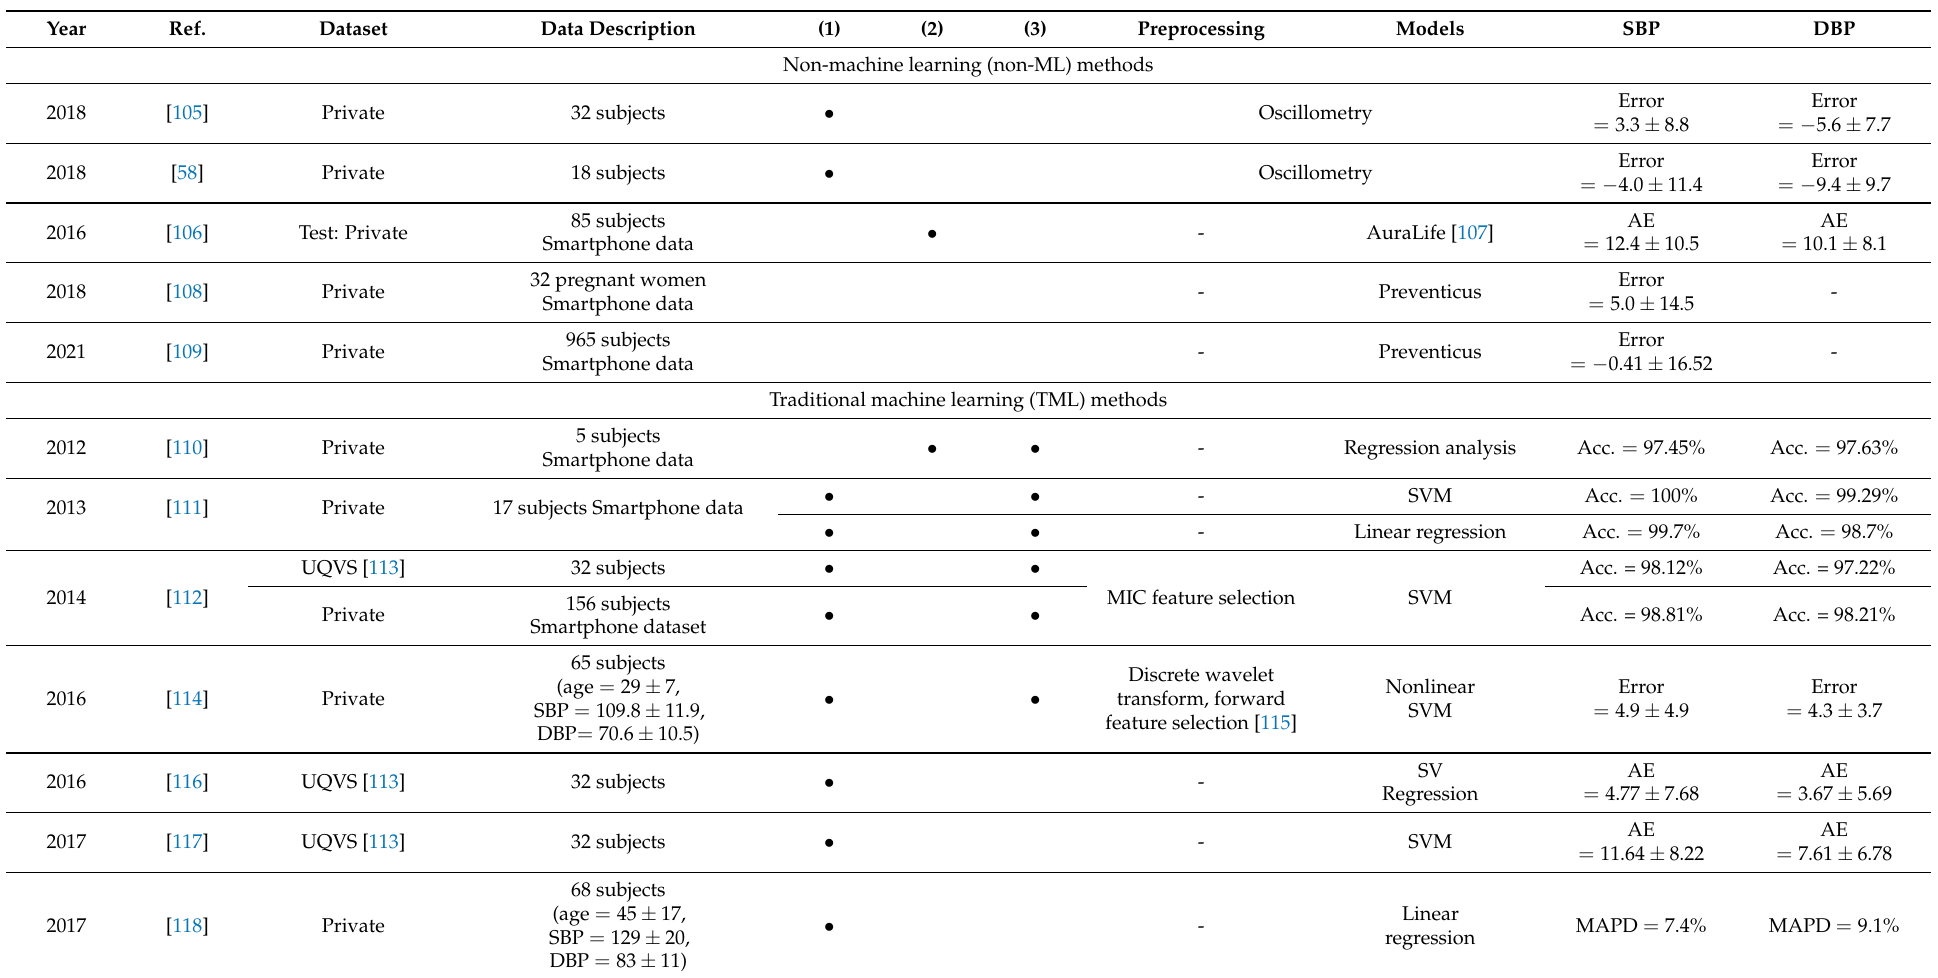
Table 2. Non-ML, TML, and DL models using PPG signals as inputs. The units for the SBP and DBP (unless specified) are mmHg. Acc. = accuracy, AE =